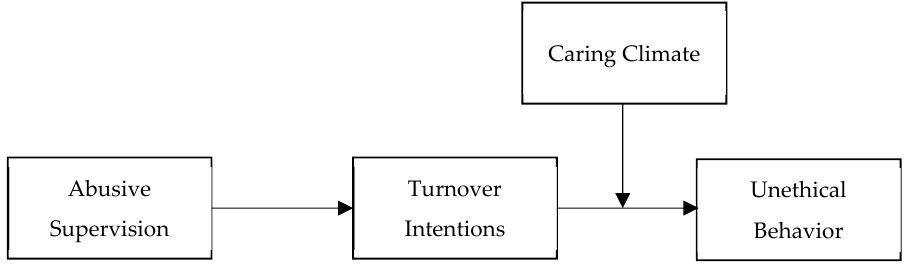
Figure 1. Theoretical model tested in this study.